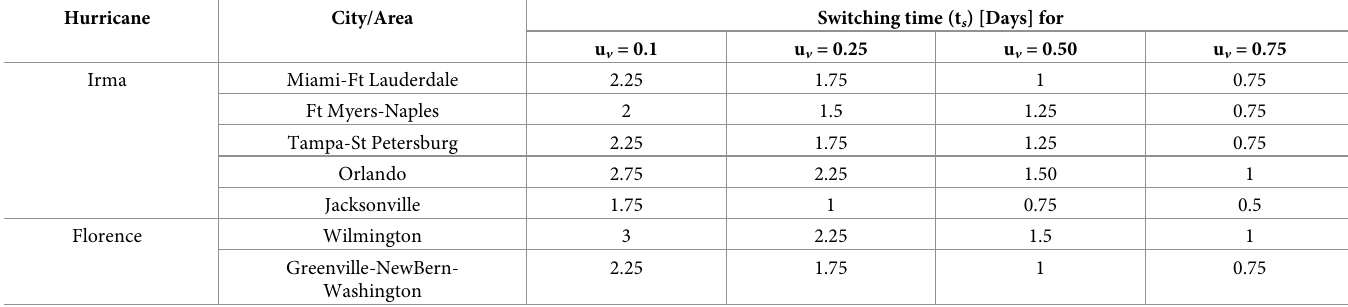
level of external intervention in terms of amount of fuel required changes every time step as the number of operational fuel stations (S(t)) changes. The application of this control strategy helps reduce the number of empty fuel stations, I(t), as shown in Fig 6(B). Fig 6(C) shows the application time and the switching time for the intervention. Here the per capita rate of